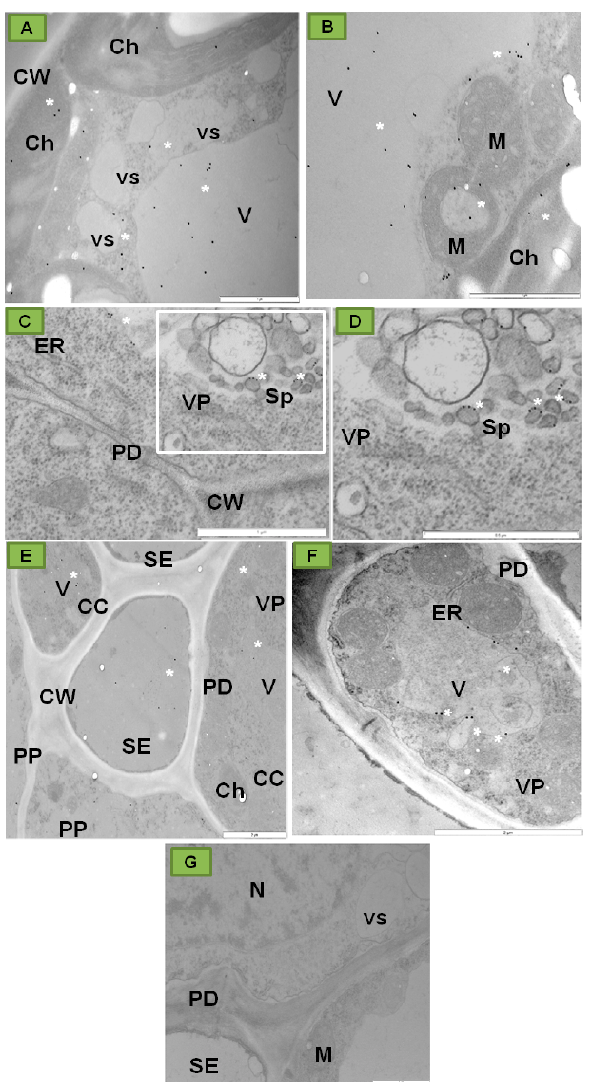
Figure 3. Immunogold localization of P1 protein (replicase) in mesophyll and phloem cells of tobacco leaf of Samsun variety 15 days after inoculation with PDV. ( A ) Colloidal gold particles associated with P1 epitope (*) in vacuoles, vesicles and chloroplasts of palisade parenchyma cell; Bar 1µm ( B ) Gold particles in palisade parenchyma cell (*) in chloroplast, vacuole, and in vicinity of mitochondria with electron-translucent area; Bar 1µm ( C ) Gold particles (*) in parenchyma cell tonoplast and in membranes of spherules. The white framed area is enlarged in ( D ); Bar 1µm ( D ) Enlarged fragment with spherules in the white frame from ( C ); Bar 0,5 µm ( E ) Epitopes of P1 protein (*) in vacuoles of phloem parenchyma and companion cells, and inside sieve tubes. Viral particles in companion cell; Bar 2µm ( F ) Colloidal gold particles (*) in companion cell vacuoles; Bar 2 µm ( G ) Control tobacco plant (mock-inoculated) phloem without of P1 localization Bar 1µm. Abbreviations: CW—cell wall, Ch—chloroplast, ER—endoplasmic reticulum, V—vacuole, vs—vesicle, M—mitochondrion, Sp—spherule, PD—plasmodesmata, SE—sieve tube, CC—companion cell, PP—phloem parenchyma, VP—viral particles, N—nucleus. Kozieł et al. [32] modified.